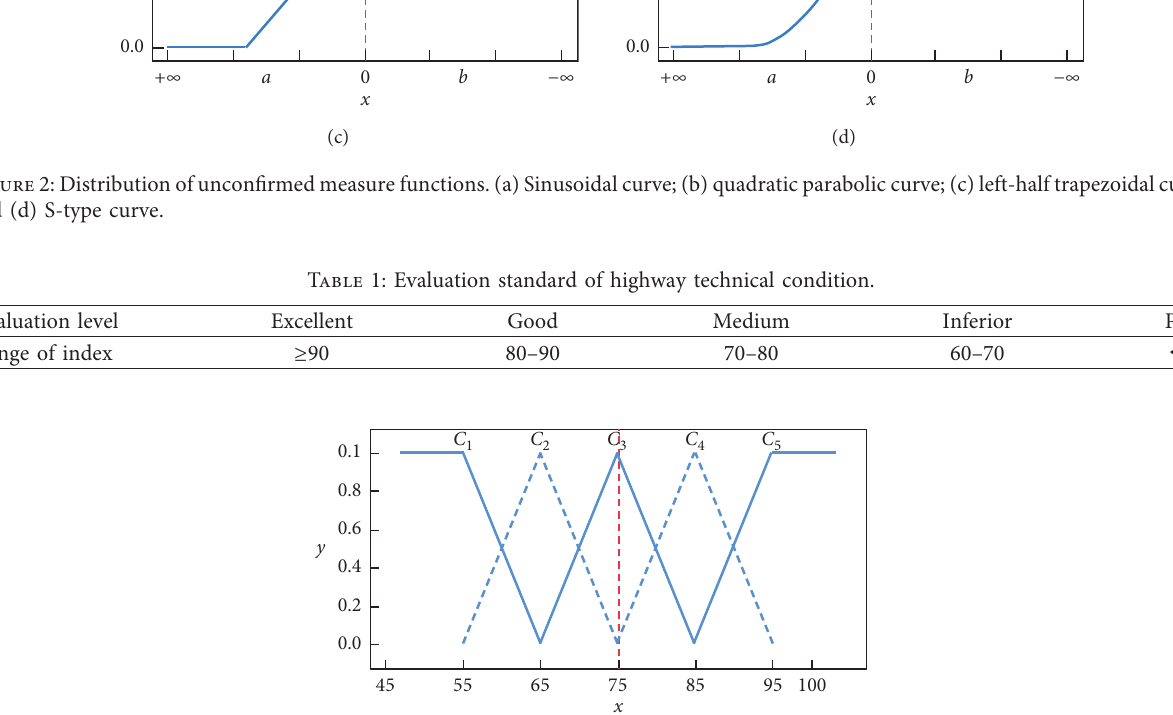
Figure 3: Unascertained measurement function of evaluation index in PQI and